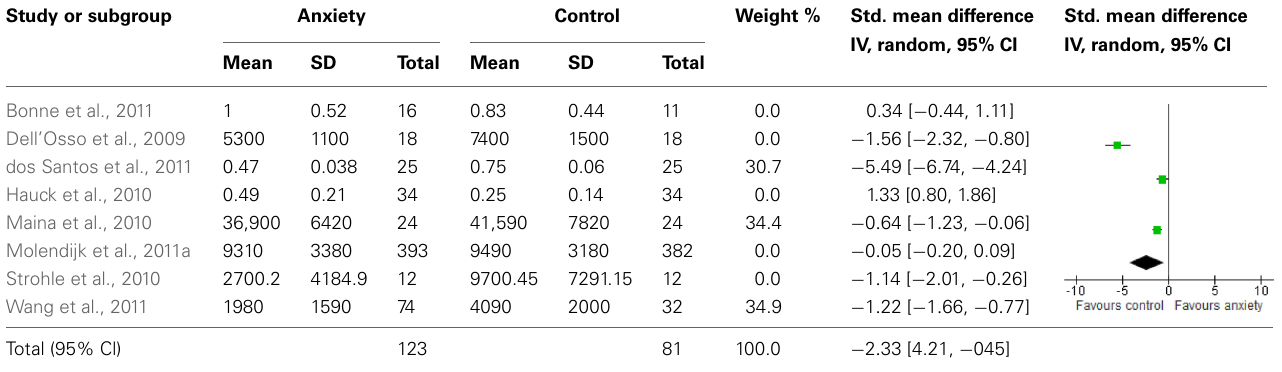
Table 7 | Subgroup analysis: OCD studies. Study or subgroup